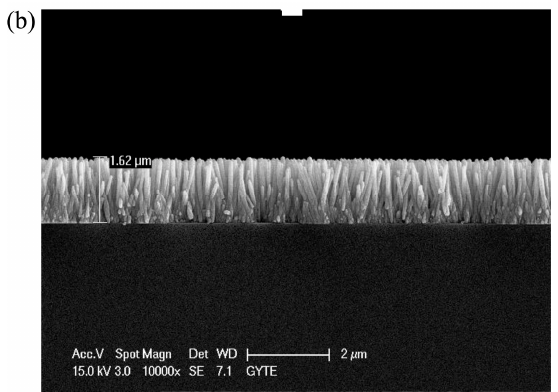
Figure 29. SEM images of ZnO nanorods ( a ) top view and ( b ) cross sectional view. Reproduced with permission from [12].